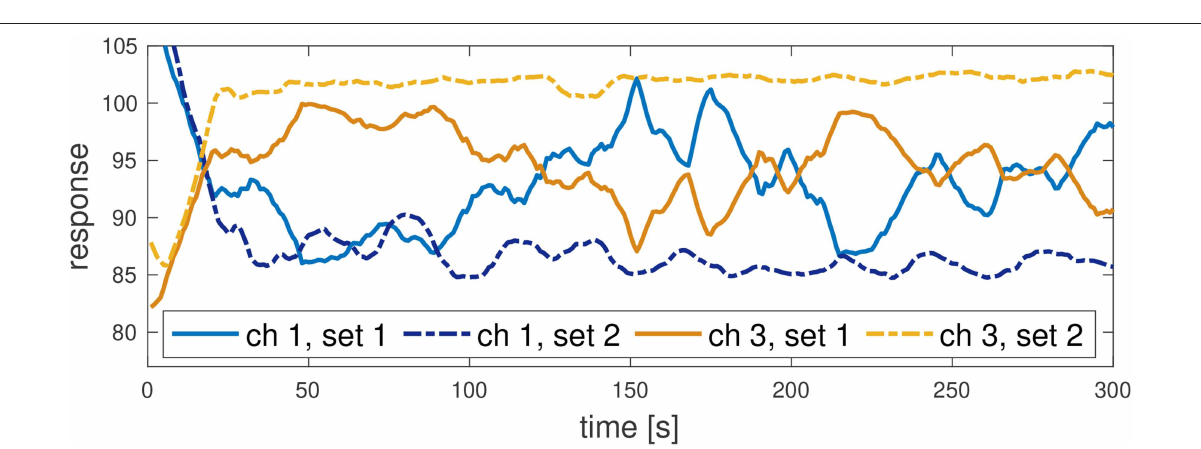
. The closeness between the is recorded and stored in s = { s i } N i = 1 unlabeled sample x (us) and the i th training sample is computed as the Euclidean distance between the two, which is defined